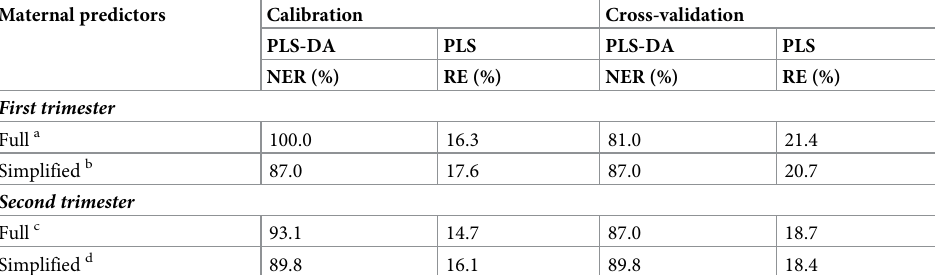
Table 4. Non-error rate and relative error of machine learning models that predict gestational diabetes mellitus and post load glycemia before and after variable selection. Maternal predictors Calibration Cross-validation PLS-DA PLS PLS-DA